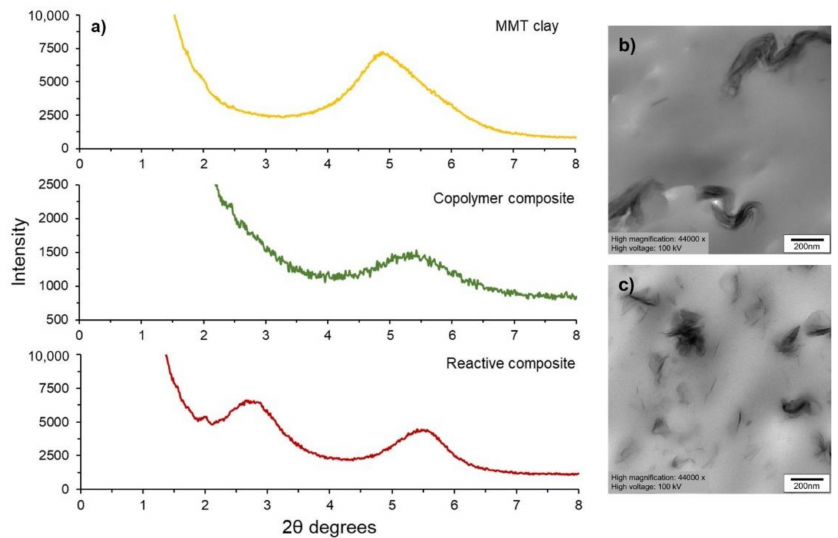
Figure 3. XRD patterns for MMT clay, copolymer composite, and reactive copolymer composite ( a ), and TEM images of copolymer composite ( b ), and reactive copolymer composite ( c ).